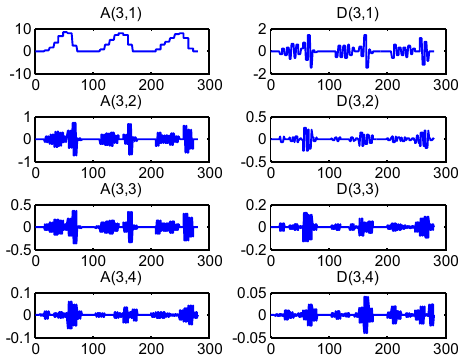
Figure 9. Coefficients of a time series of GRF measured from the heel. The x -axis denotes the number of the length of data while the y -axis denotes the amplitude of those coefficients.